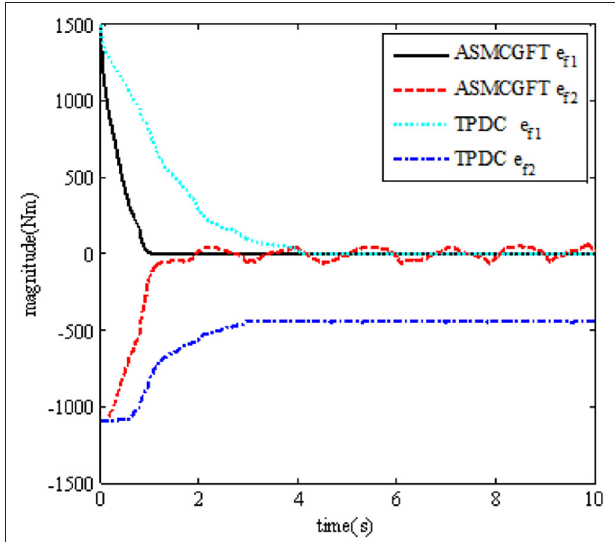
FIGURE 6 | Comparison of master-slave robot contact torque